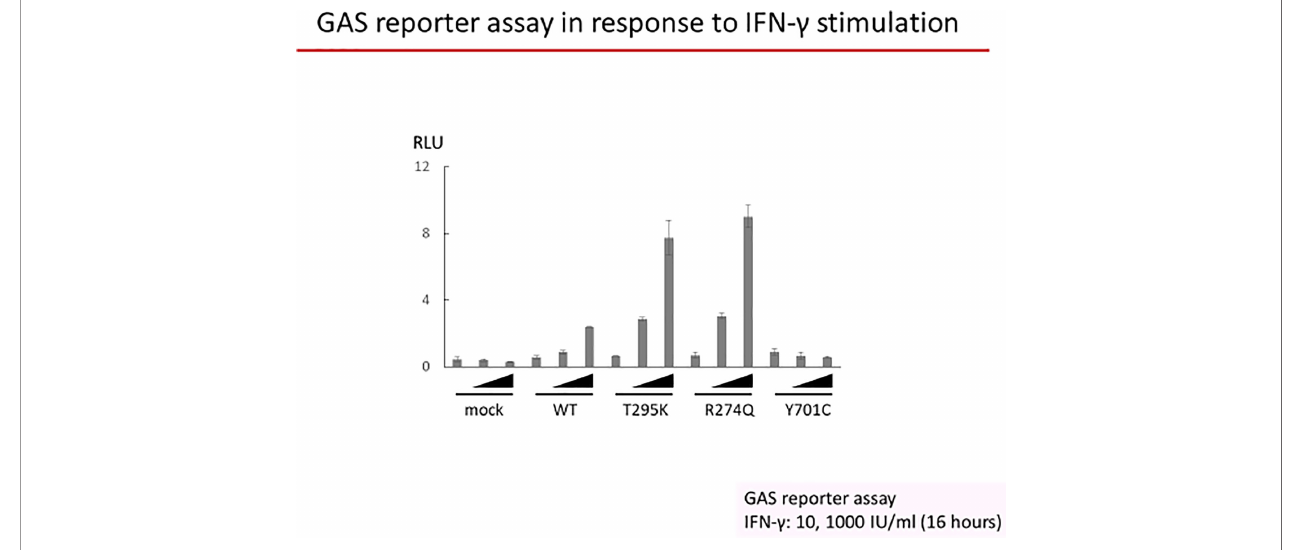
FIGURE 3 | U3C cells were transfected with a mock vector, a WT allele, or three mutant alleles of STAT1 (encoding T295K, R274Q, or Y701C STAT1). Luciferase activity under a GAS promoter was evaluated after 16 h of stimulation with 10 or 1,000 IU/ml of IFN- g or without